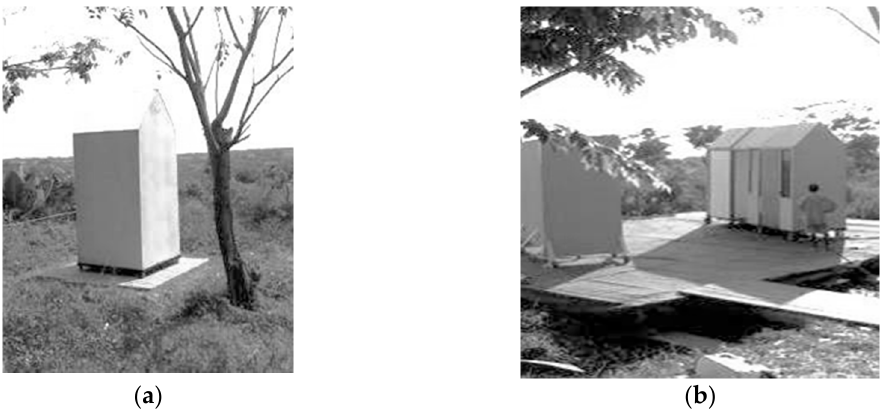
Figure 4. Placement of building model in the location near the runway; ( a ) control building model; ( b ) building block model was rotatable on its axis.